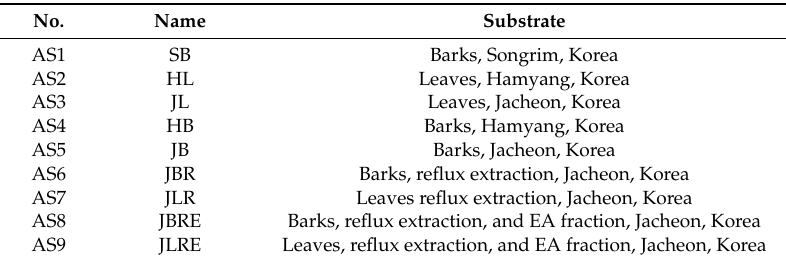
Table 1. Information on Alnus sibirica (AS) extracts used in experiments.